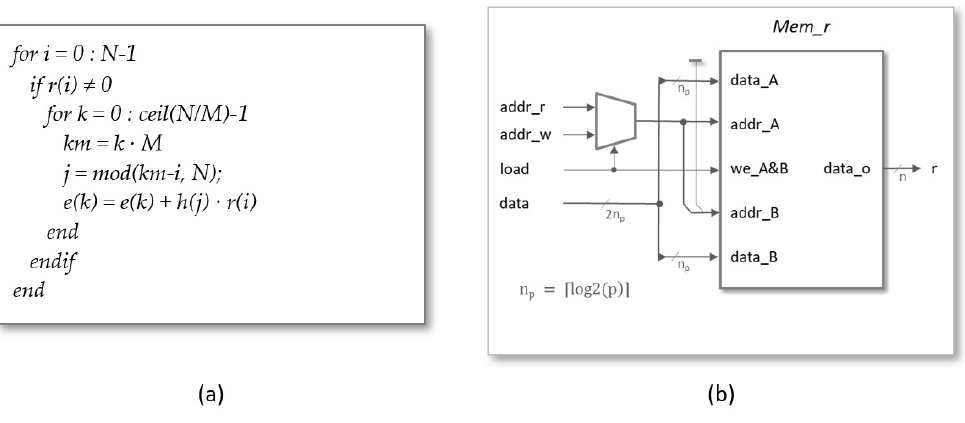
Figure 6. ( a ) Pseudocode used to generate the indices for multiple arithmetic units. ( b ) Memory block used to store the coefficients of the polynomial r ( x )